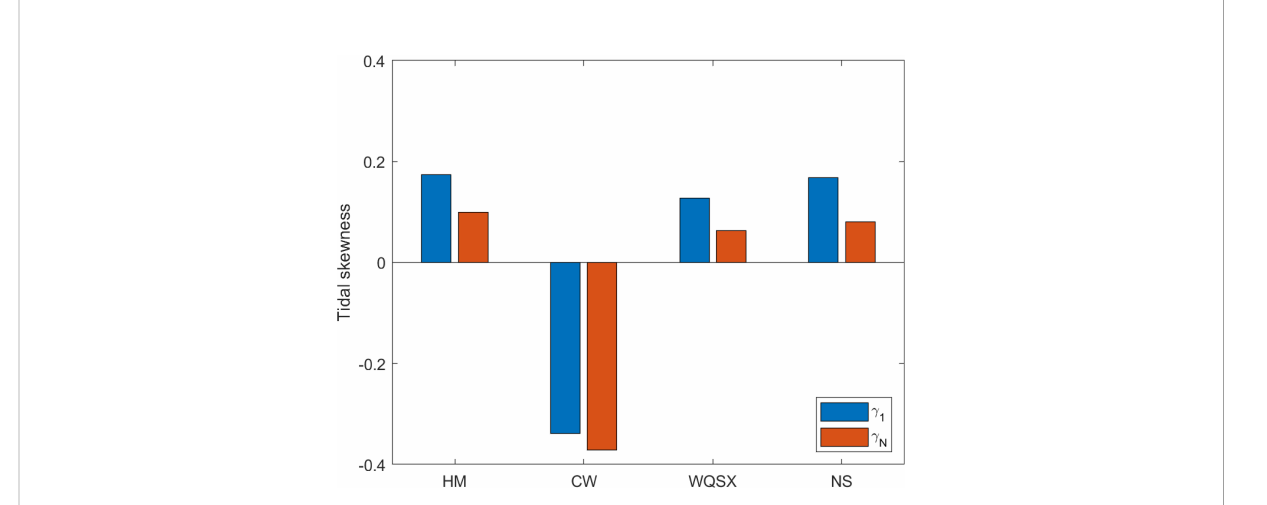
FIGURE 3 Comparison between the statistical skewness of the water-level time derivative (blue bar) and the total tidal skewness estimated by tidal constituents (red bar) for HM, CW, WQSX, and NS tidal gauging stations in